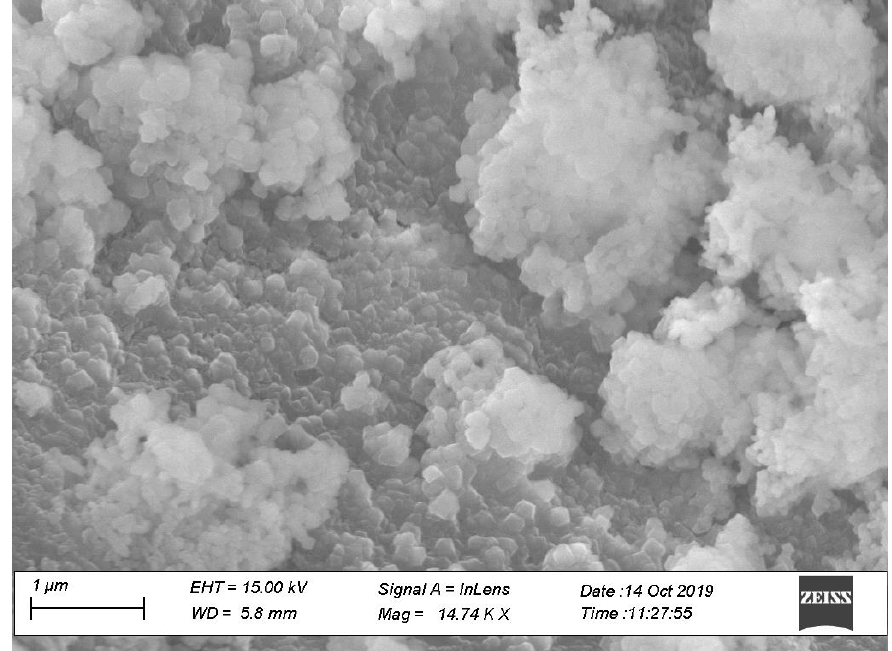
Figure 3. Agglomerated nano CaCO 3 in the Ordinary Portland Cement (OPC) concrete mix with 1% nano CaCO 3 (OP-1).